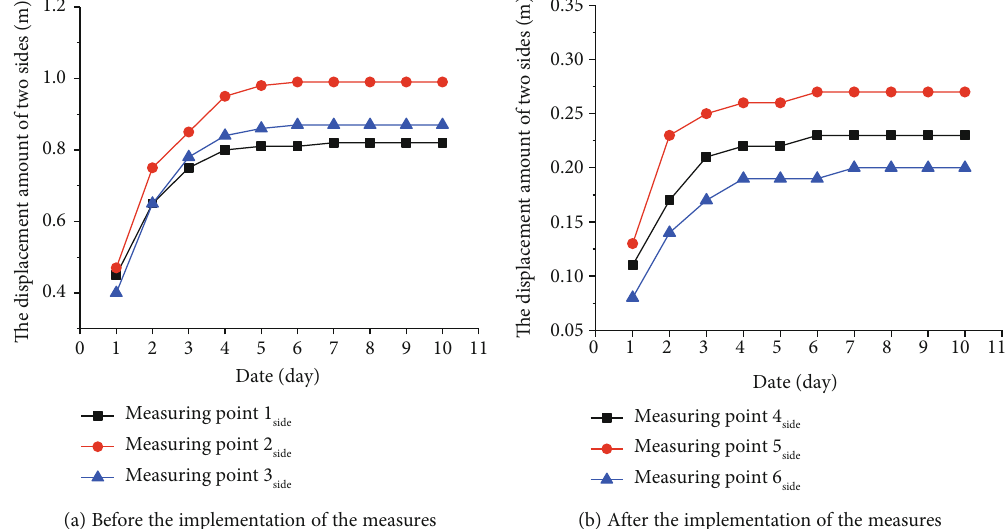
Figure 20: Comparison of the displacement amount of two sides before and after the implementation of antiscour measures on the working